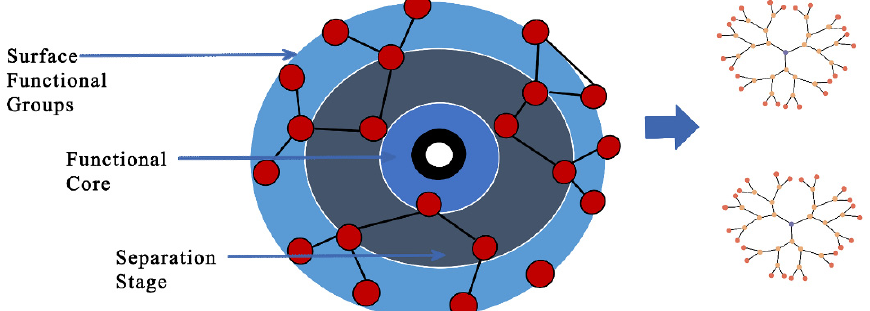
Figure 5. Illustration of dendritic molecular structures with a central core, repeating branches, and terminal reactive functional groups. They can be classified as polymers and hyperbranched polymers with convergent and divergent architectures, depending on their molecular nature weight. Their nanostructure provides dendrimer–drug conjugation via different interactions such as electrostatic and hydrophobic/hydrogen bonds or the capacity for drug encapsulation within the central cavity and/or between the dendrons (branches). Adapted and modified from [87] under the Creative Commons license.